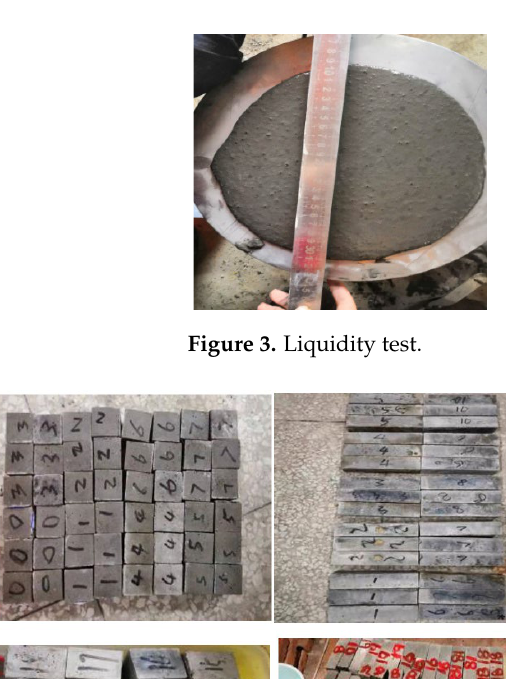
Figure 3. Liquidity test.